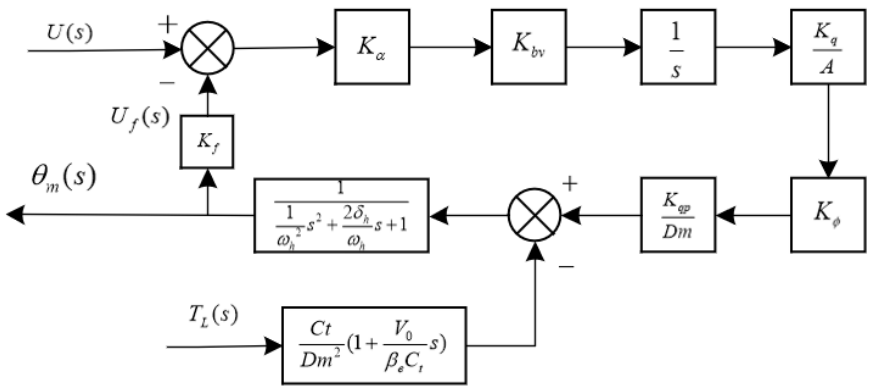
Figure 3. Block diagram of the mathematical model of pump-controlled motor.